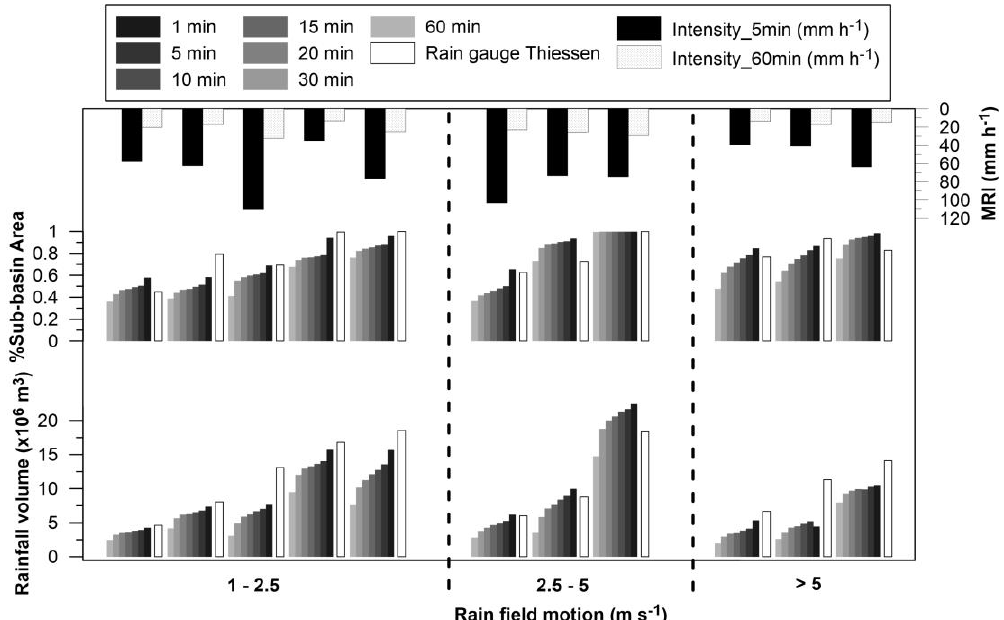
Figure 13. Event discretization according to the horizontal rainfall motion for the seven temporal resolutions and for 0.5-km spatial resolution (the same results were found when using the two other spatial resolutions). The precipitated water volume, the area percentage covered by rainfall, and the maximum intensities recorded for 5 min and 60 min are shown.